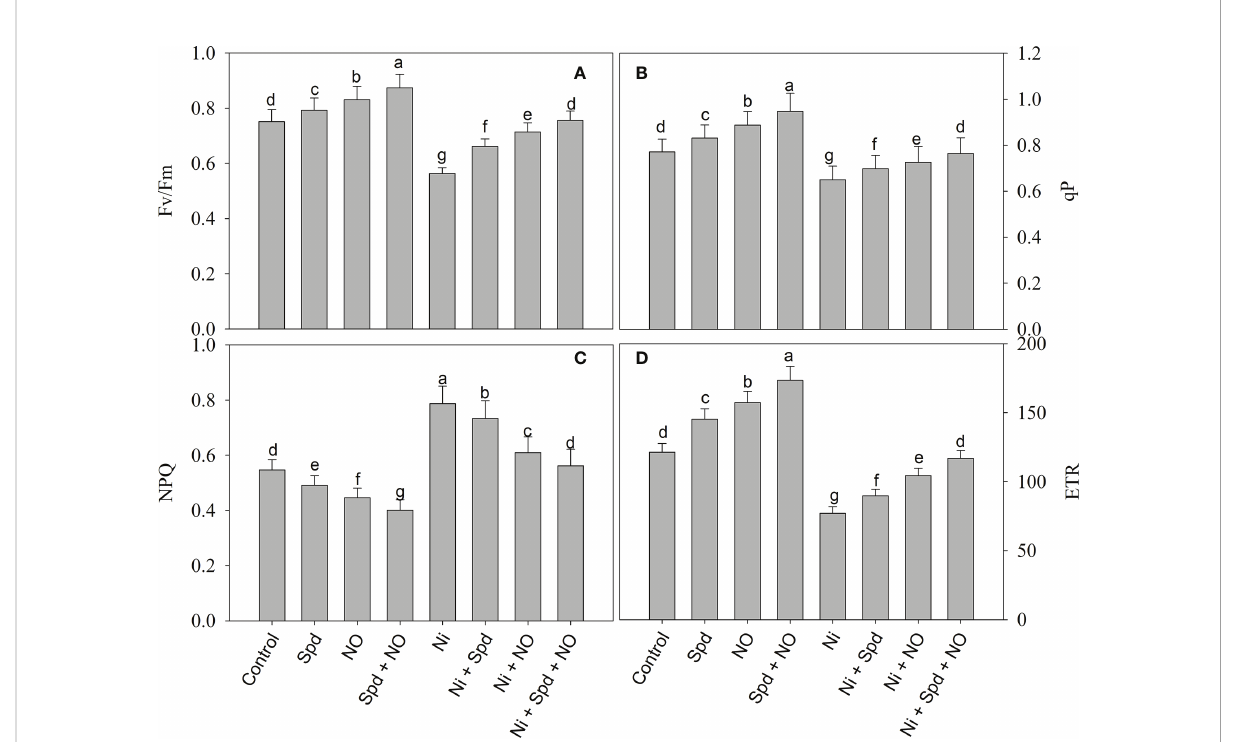
FIGURE 3 Effect of nitric oxide (50 µM) and spermidine (100 µM) supplementation on (A) PSII activity (Fv/Fm), (B) photochemical quenching (qP), (C) non photochemical quenching (NPQ) and (D) electron transport rate (ETR) in Solanum lycopersicum L. subjected to nickel stress. Data is mean (±SE) of four replicates and different letters on bars denote signi fi cant difference at P <